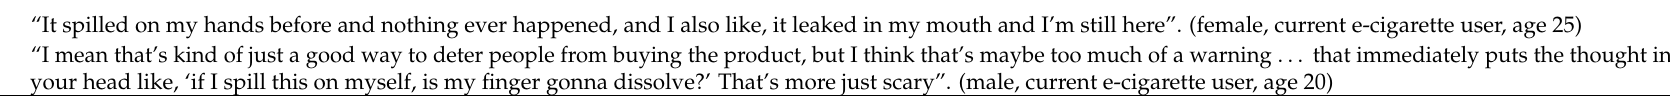
Table 2. Select example quotes of participants’ message perceptions, by message and